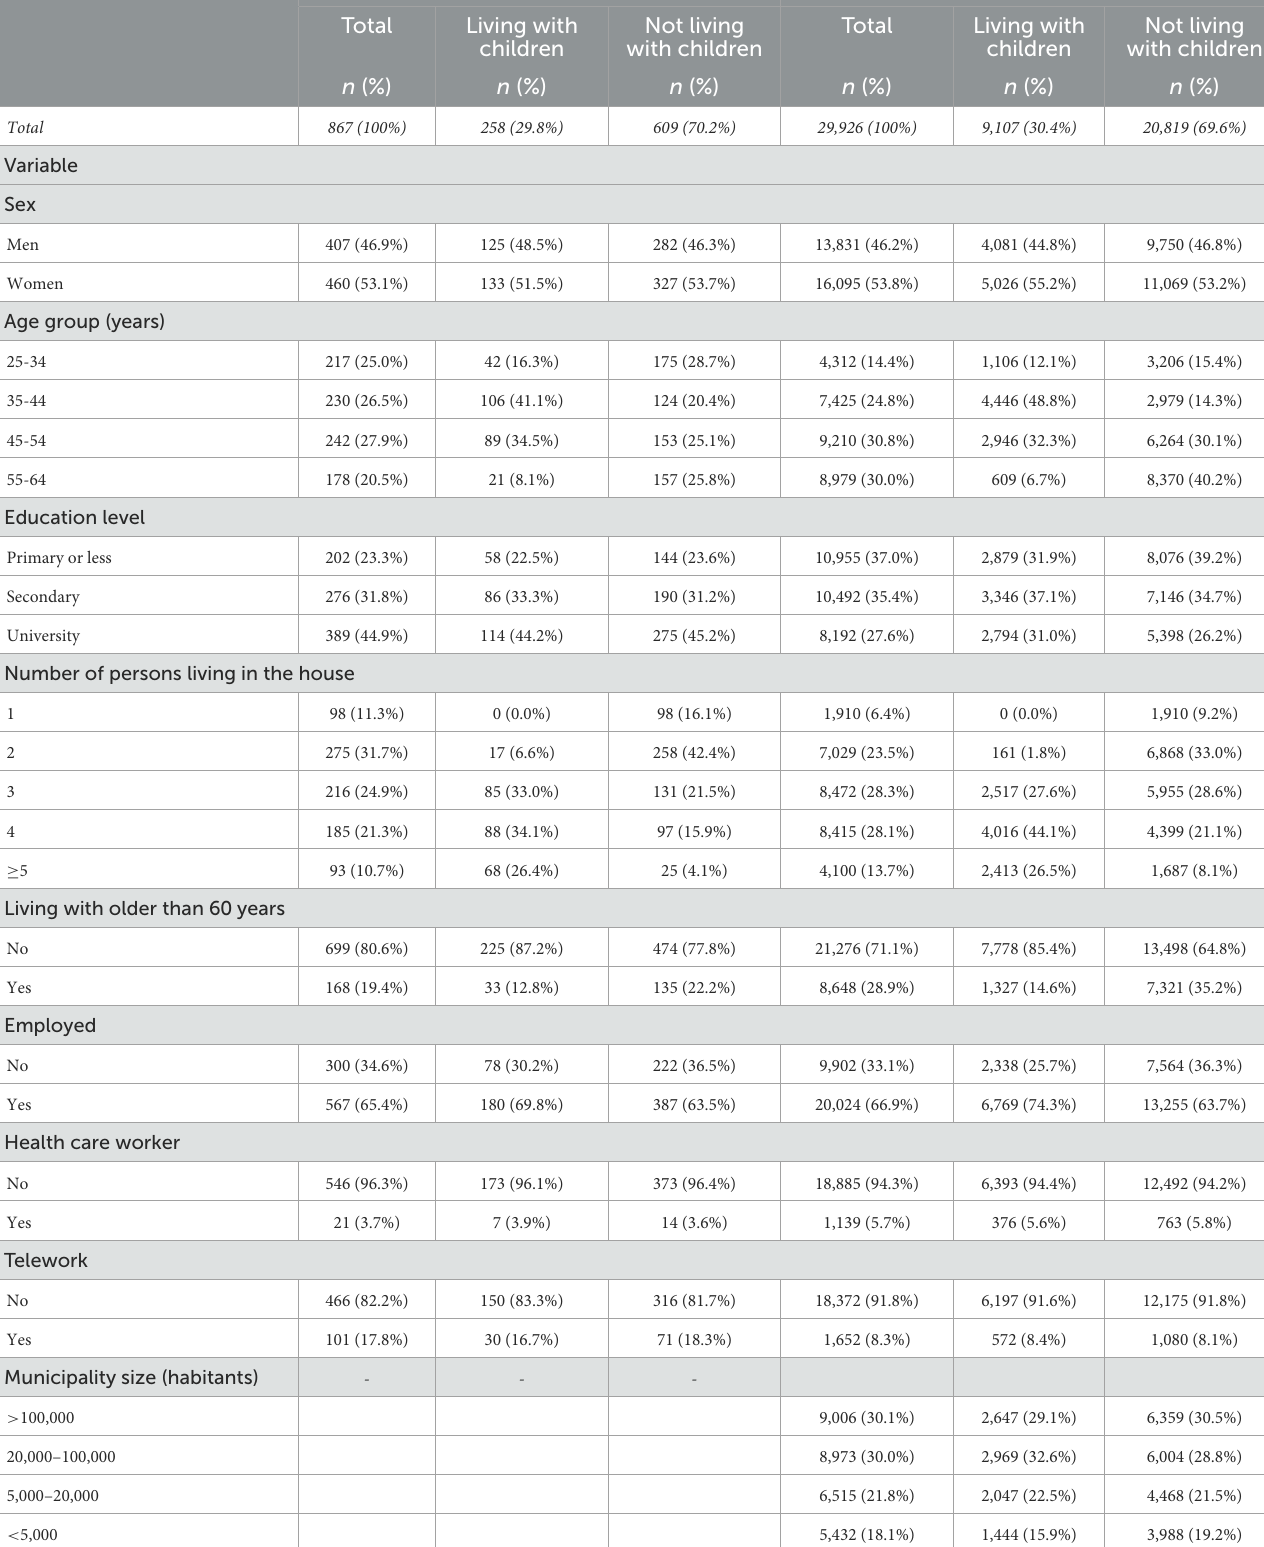
TABLE 1 General characteristics of COSMO-SPAIN and ENE-COVID participants aged 25–64 years according to the presence of children in the household, November